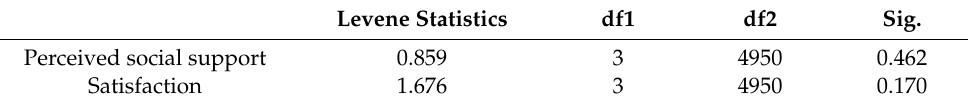
Table 4. Test for homogeneity of variances—perceived social support and satisfaction. Levene Statistics df1